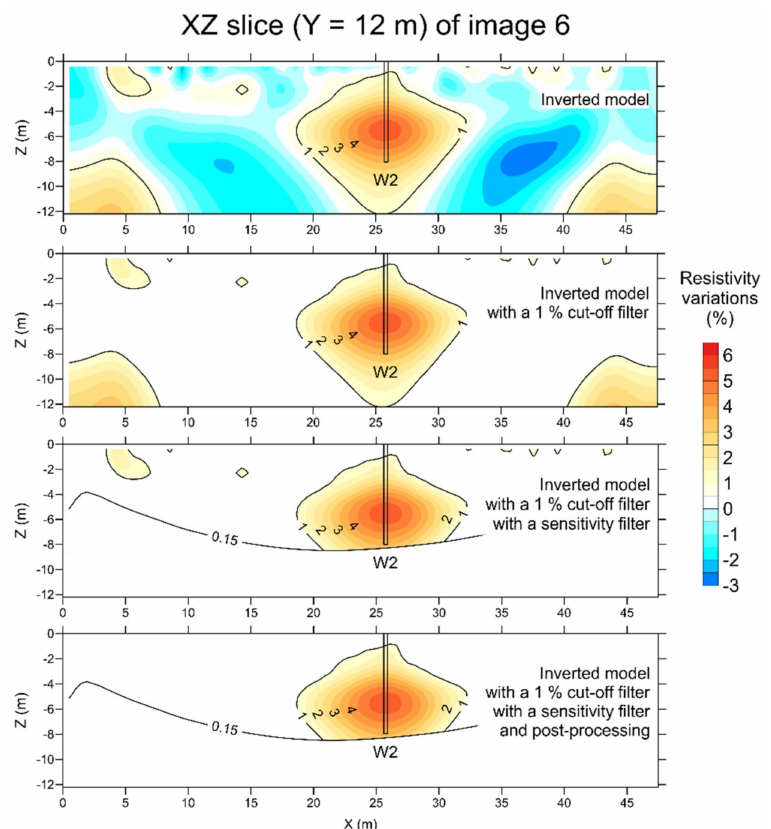
Figure 7. XZ slice (Y = 12 m) of the full 3D ERT image 6 showing the unfiltered changes in bulk electrical resistivity (1st panel), the application of the 1% cut-o ff filter calculated with the background resistivity variations (2nd panel), the application of the relative sensitivity filter (3rd panel), and the removal of artefacts in the very shallow subsurface (in the first 2 meters where no temperature changes due to the heated water injection is expected) (4th